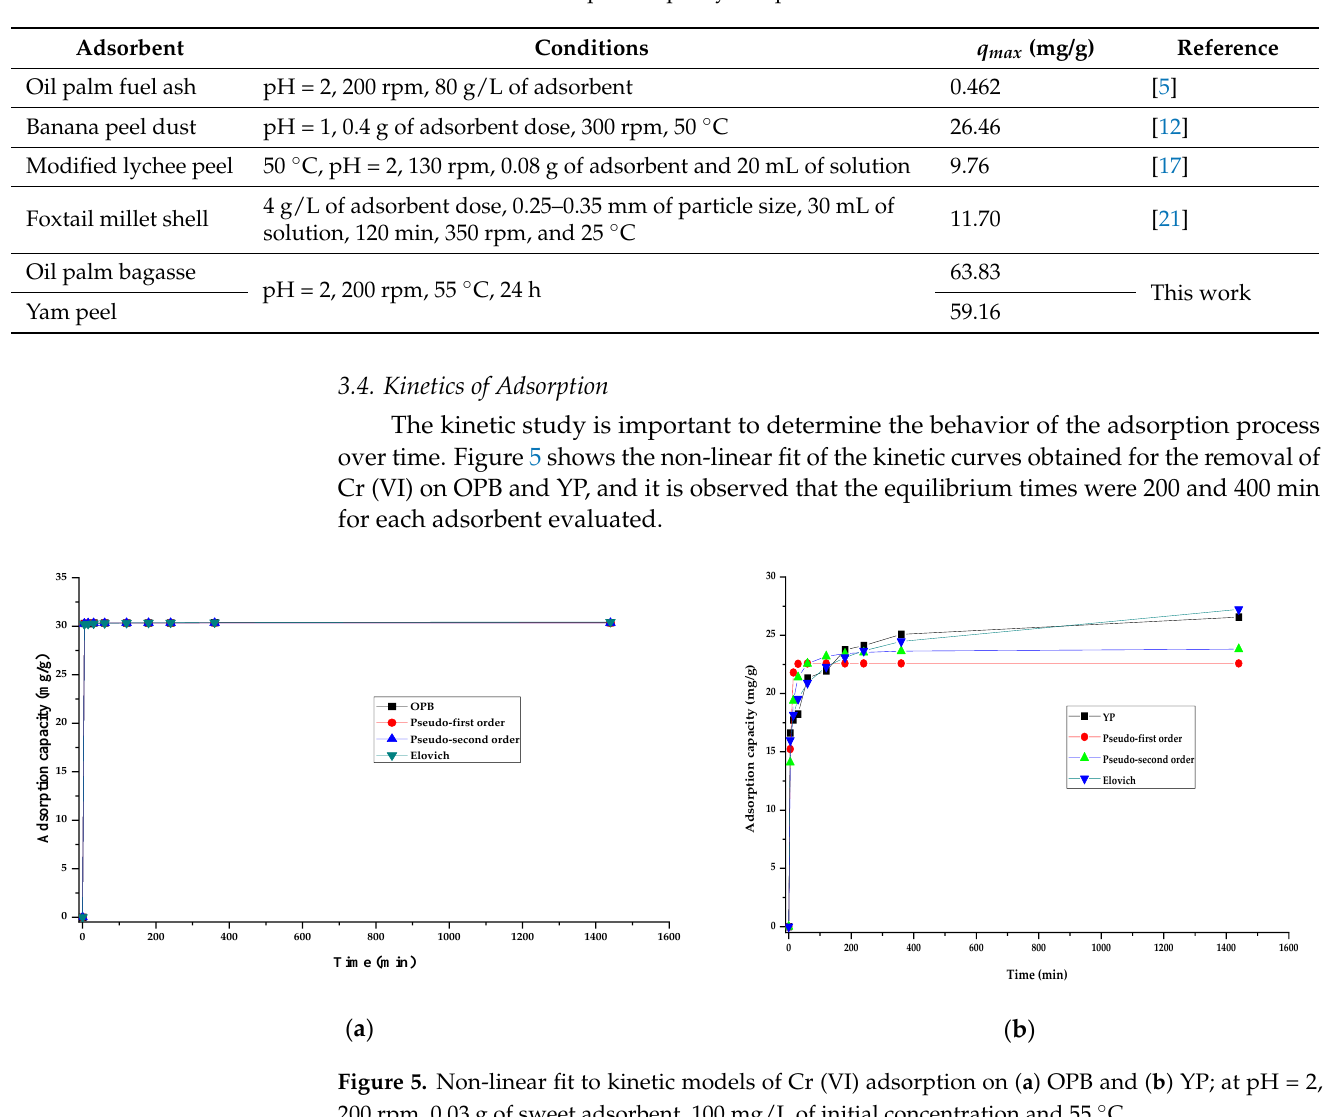
Table 7. Maximum adsorption capacity comparison of different adsorbent materials.